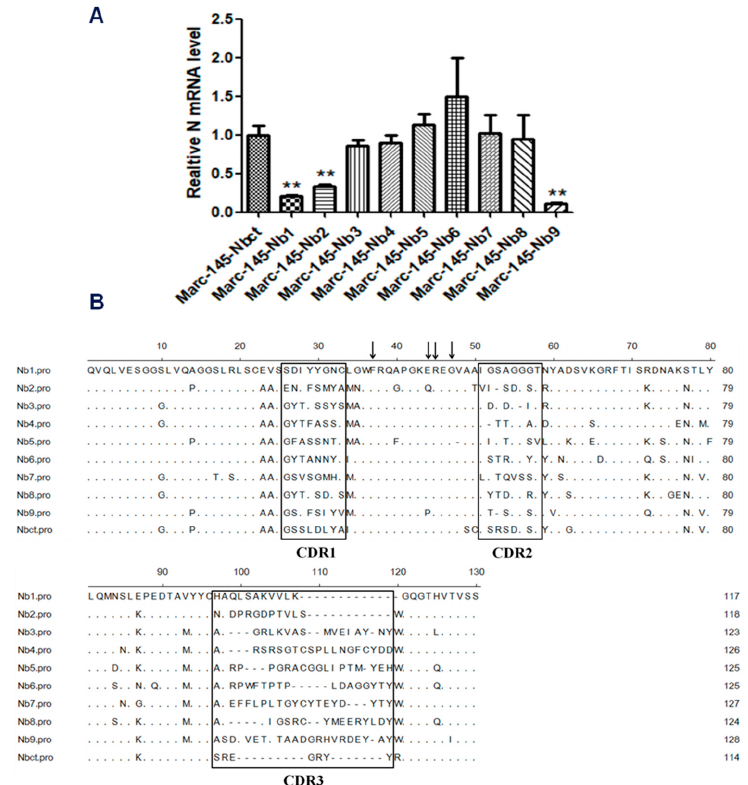
Figure 3. Characterization of Marc-145–Nbs subclones after PRRSV infection and sequences analysis. ( A ) Amplified clones of Marc-145–Nbs were incubated with PRRSV JK100 (1 MOI). After culturing for 48 h, cells were harvested and relative PRRSV N mRNA levels were detected using real-time PCR. Beta actin served as internal reference (**, P < 0.05). ( B ) Sequence alignment of selected antiviral Nbs. Complementarity-determining regions (CDRs) are denoted by the thick-line boxes. Four conservative hallmark residues of Nbs in FR2 (Val37Phe, Gly44Glu/Lys, Arg45Leu, and Trp47Gly) are denoted by the arrows.